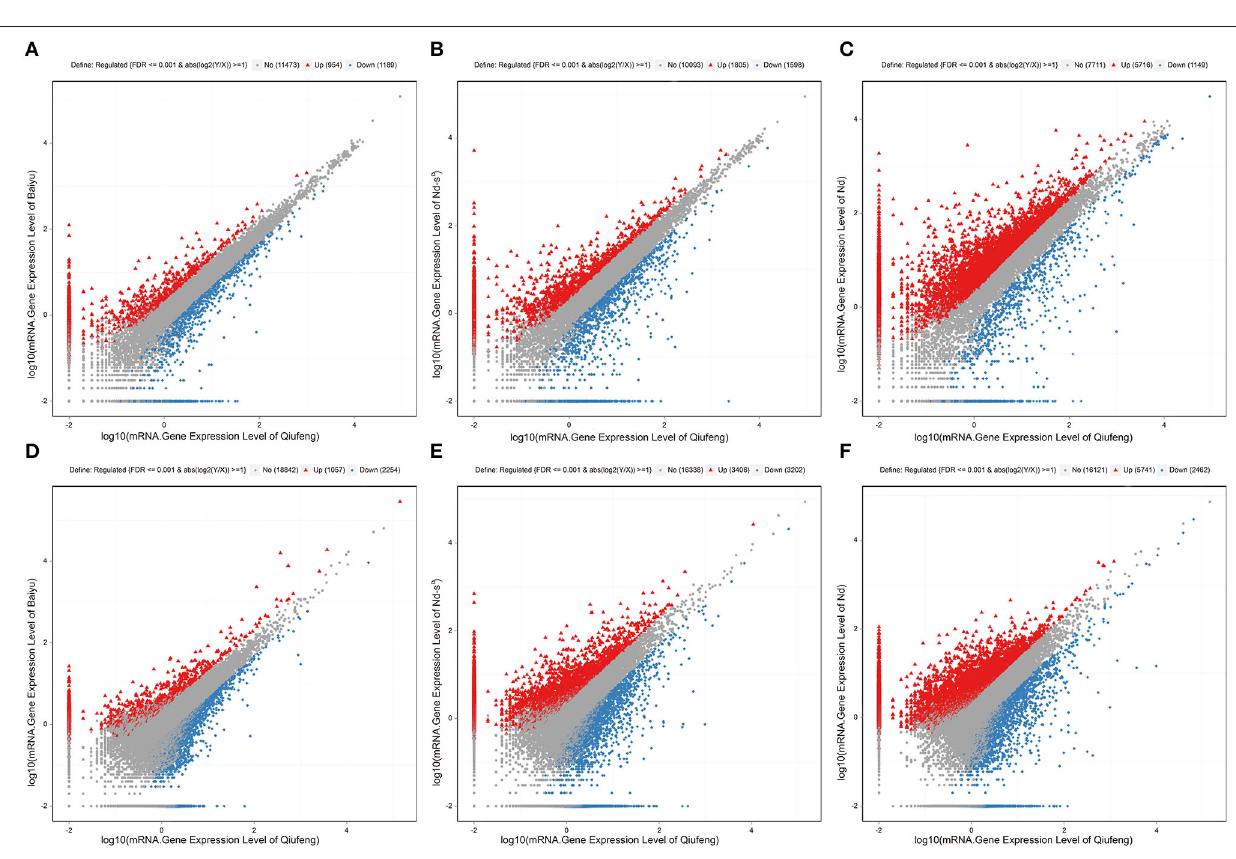
in a recent study (Hu et al., 2019b) resided within the 10 kb upstream/20 kb downstream of seven lncRNAs. LncRNAs